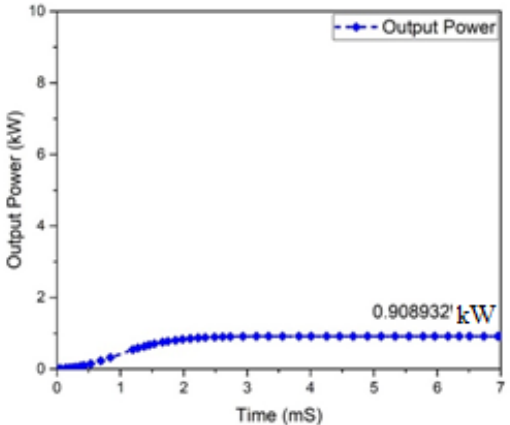
Figure 14. Output power of proposed boost converter.